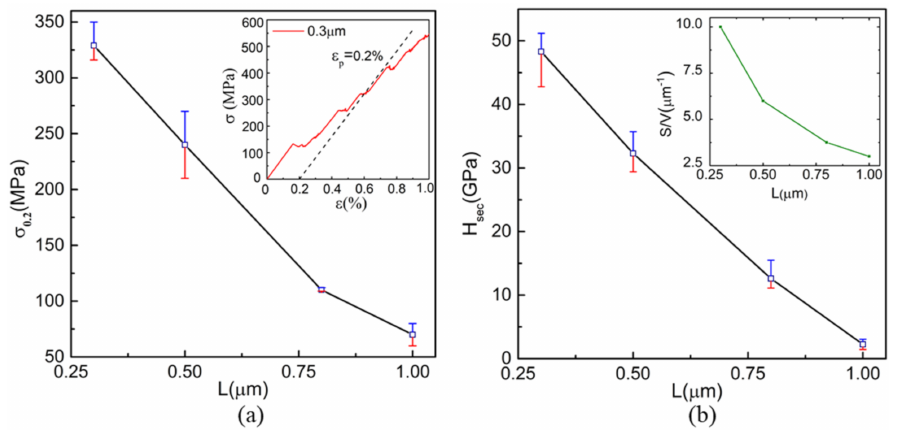
Figure 11. The yield stress at 0.2% plastic strain offsets, σ 0.2 , ( a ) and average secant hardening modulus, H ave , ( b ) versus the width of micropillars. The inset in ( a ) shows the capture of the yield stress from the one stress–strain curve, and the inset in ( b ) is the ratio of surface area to volume for each